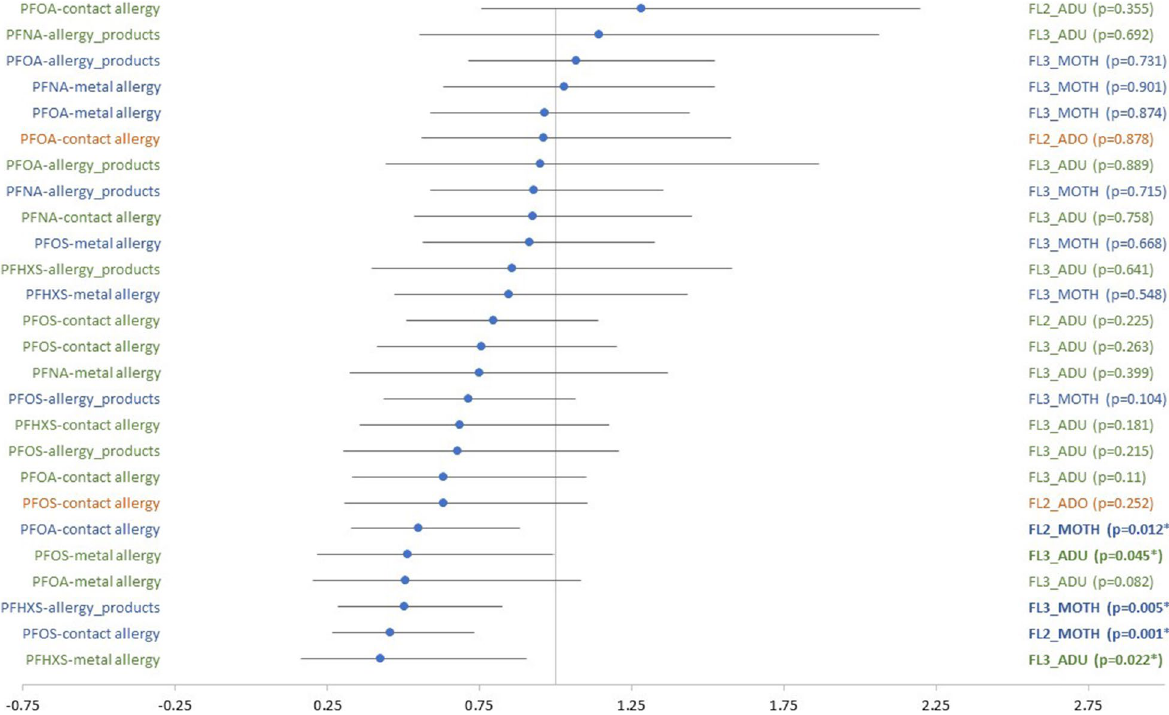
Fig. 4 Forest plot of the odds ratios (ORs) of the allergy outcomes: contact allergy (only in FLEHS-2), allergy to metals (only in FLEHS-3), product allergy (only in FLEHS-3) in relation to the measured PFAS in the different FLEHS studies (with FL2 FLEHS-2, FL3 FLEHS-3, ADO adolescents, ADU adults, MOTH mothers). The OR (95% confidence interval) is expressed for an interquartile increase in exposure . Confounders and covariates that were included at the start of the stepwise multiple regressions are mentioned in Additional file 1: Tables S2, S3, S4, S5 and